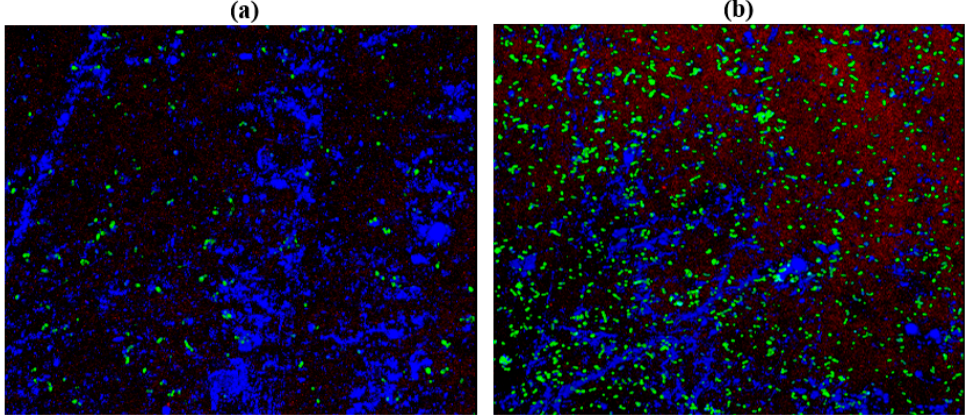
( a ) 12 h; ( b ) 24 h. All images were captured at 40 × magnification under oil immersion.